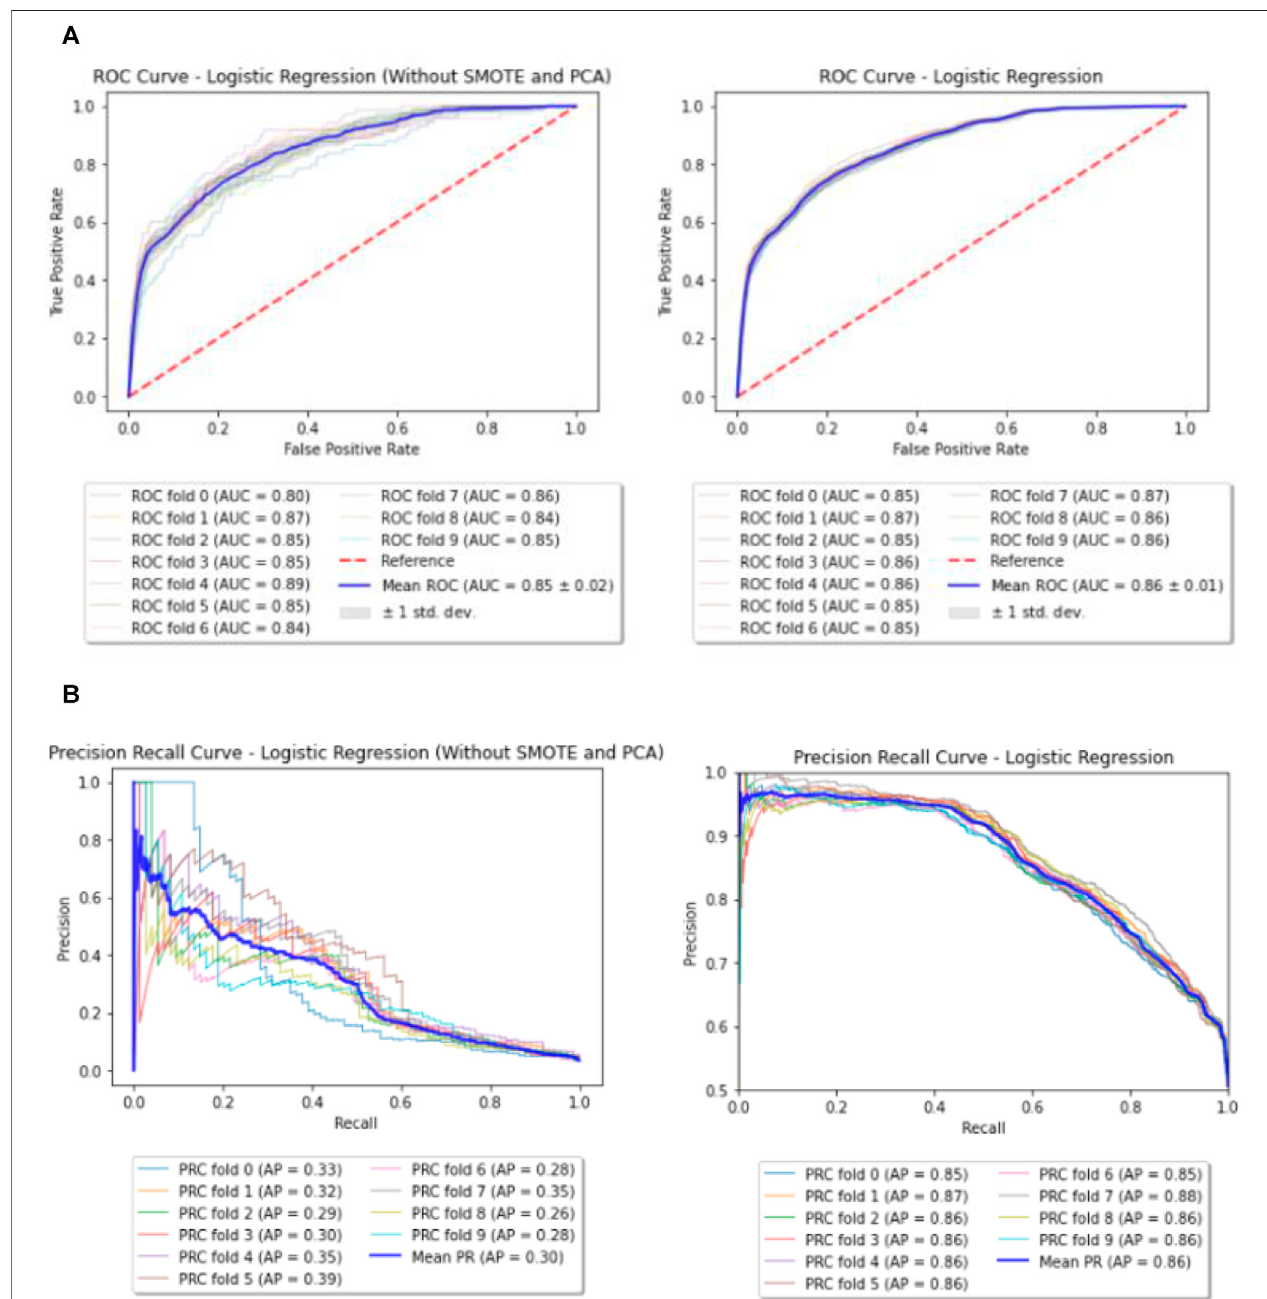
FIGURE 3 | (A) Baseline — ROC curves (before and after performing SMOTE and PCA). (B) Baseline — Precision Recall (PR) curves (before and after performing SMOTE and